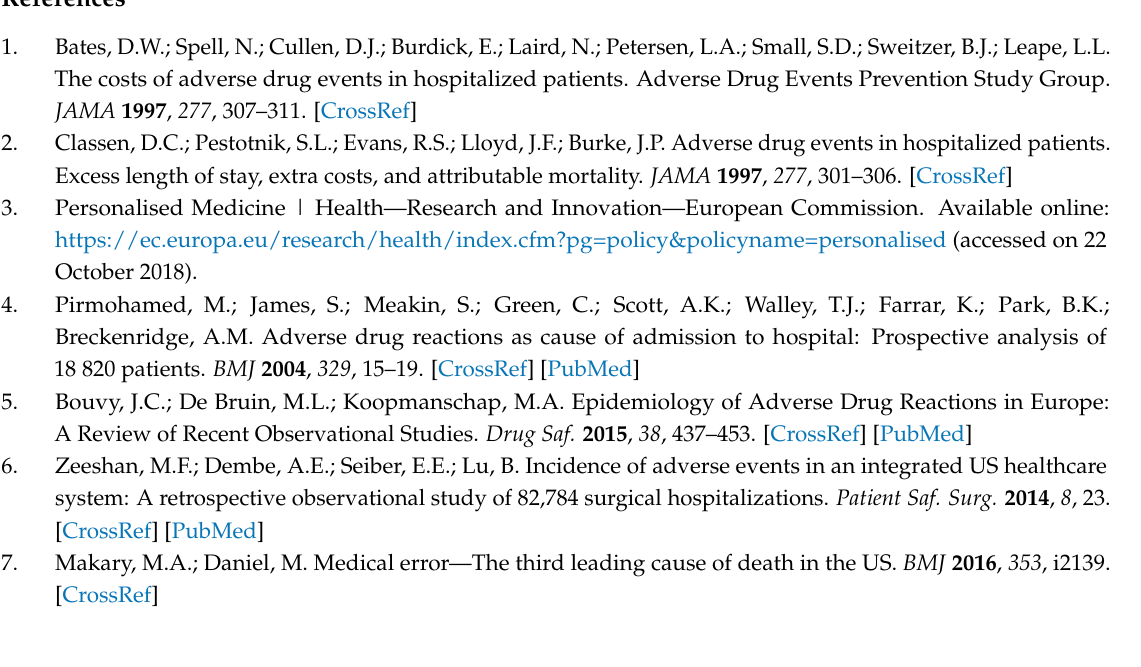
Table S1: Selected MedDRA level 2 classes in FAERS. Table S2: MedDRA level 2 and 3 categories of the general MedDRA class ‘Social circumstances’, Table S3: Top 20 non-physiological (disease, condition, side-effect) MedDRA level 3 reaction categories in FAERS. Supplementary_Data.xls contains reaction (MedDRA level 3) statistics and DDI-outcome